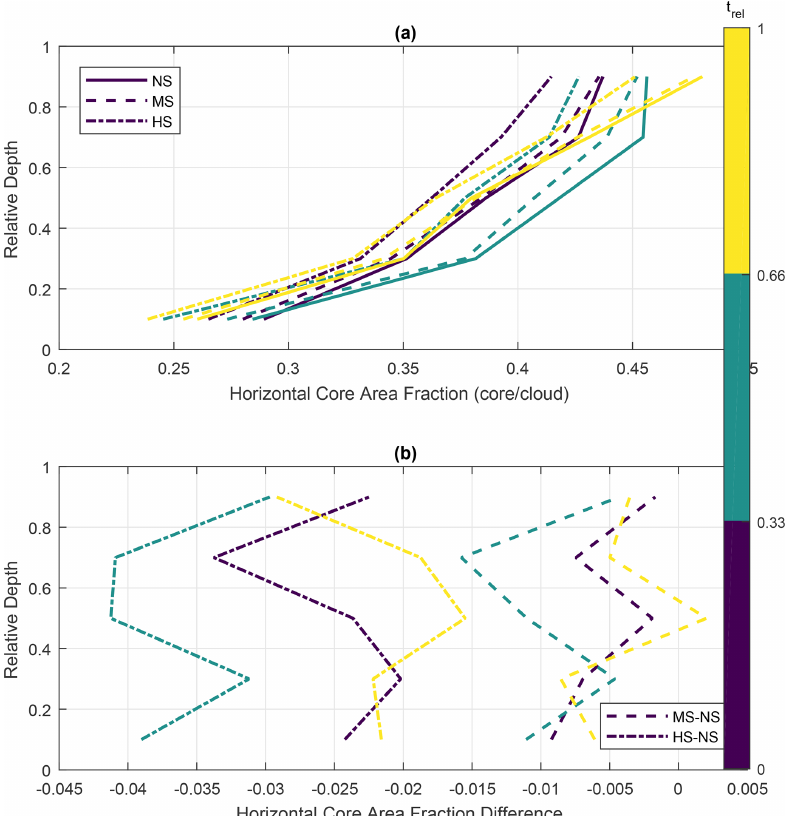
Figure 11. Similar to Fig. 8, but the profiles represent the average core area fraction (i.e., the ratio of the core and cloud areas) in horizontal slices through the clouds. Panel (a) shows the actual fraction values, while panel (b) shows the differences between the MS/HS runs and NS. The standard deviation of the area fraction represents approximately 70% of the averages close to cloud base, decreasing to 50% close to cloud